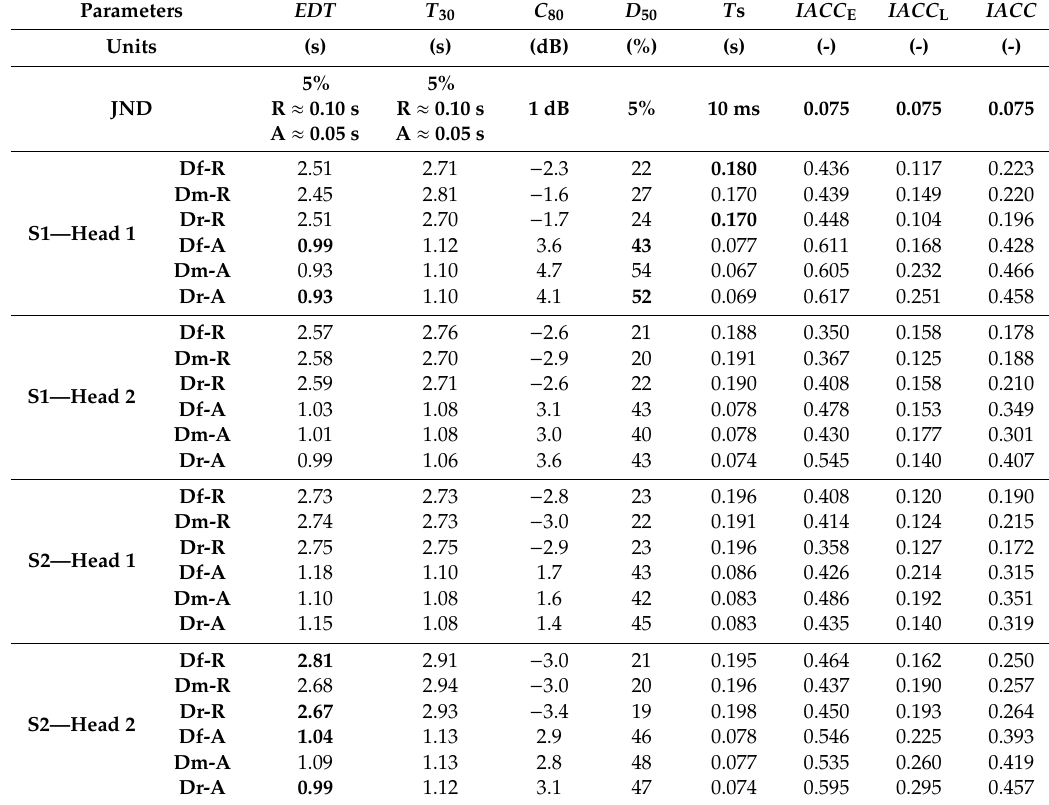
Table 4. Objective acoustic parameters obtained at the head position for the compared pairs of configurations. The di ff erences above the JND between Df and Dr values in the reflective (-R) and absorptive (-A) conditions have been highlighted in